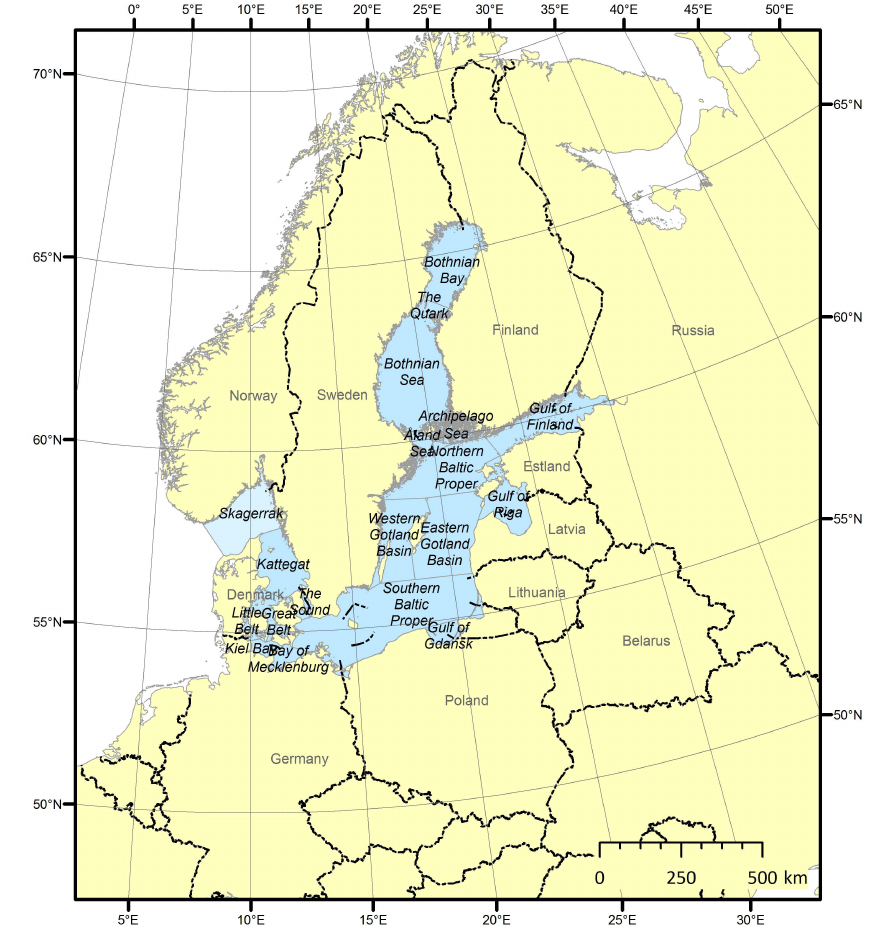
Fig. 1. Overview map of the Baltic Sea and the surrounding Figure 1: Overview map of the Baltic Sea and the surrounding countries. 2